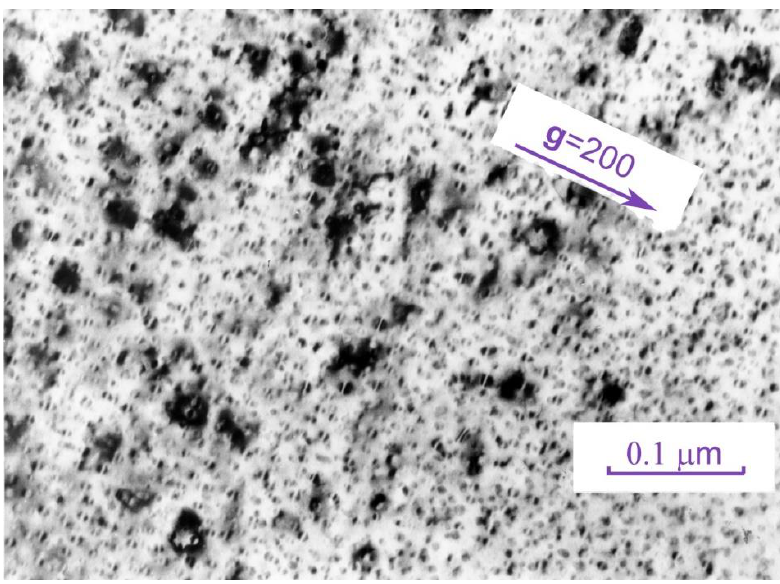
Figure 7. TEM photograph of an Al-rich alloy which was quenched from T t to RT and aged at 350 K for 1 day. A dense system of initial Guinier–Preston zones (GPZ) and initial β precipitates are visible. A